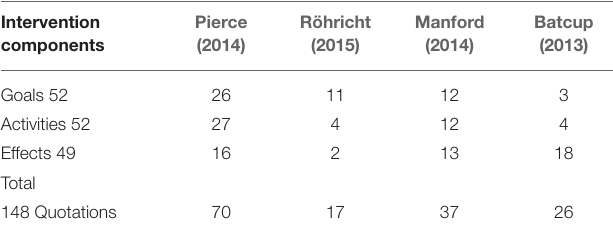
TABLE 3 | Overview of intervention components per